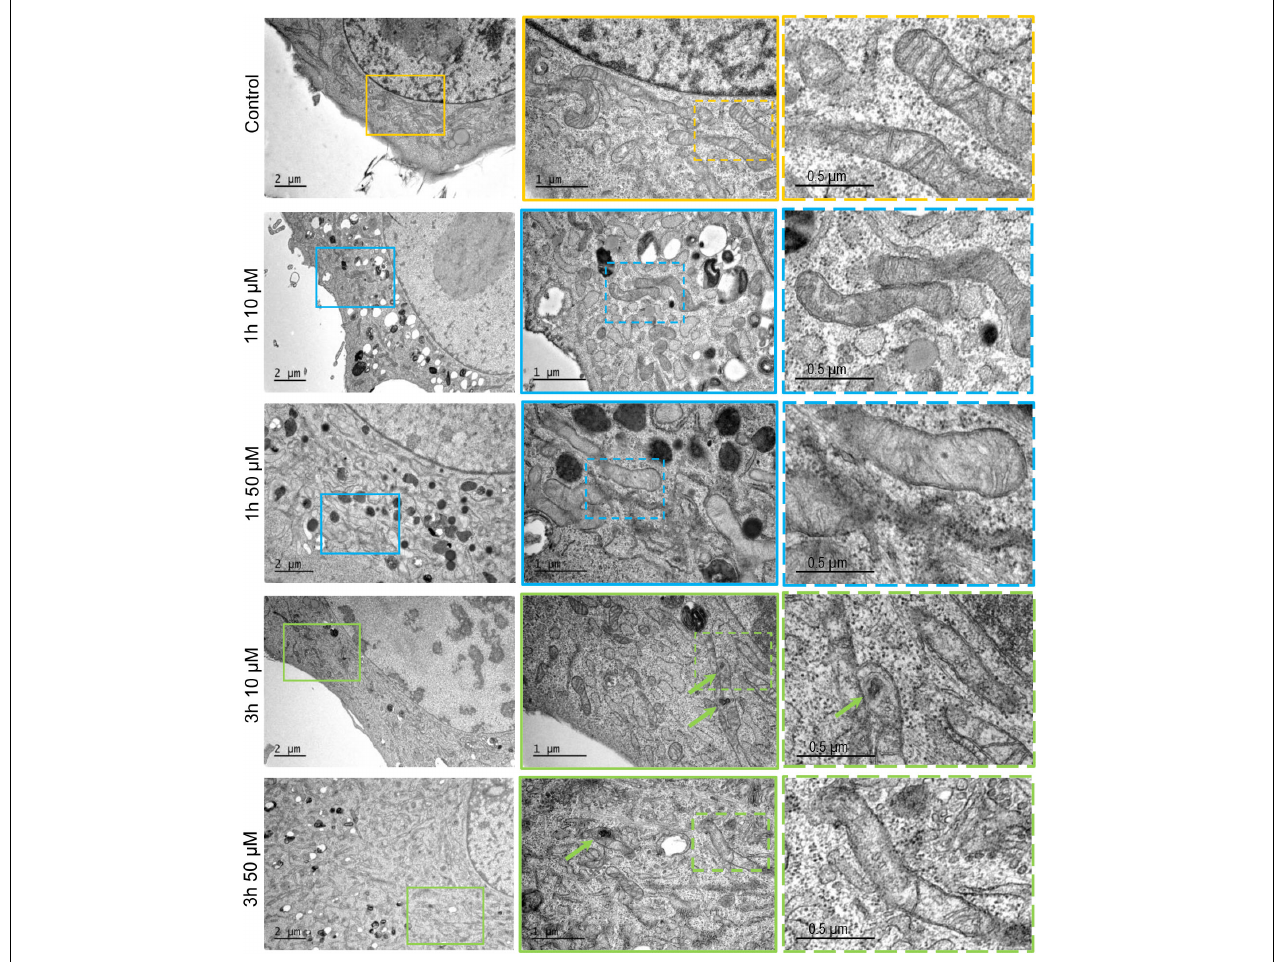
FIGURE 2 | Visualization of mitochondria and their ultrastructure in fibroblasts treated with 3O-C 12 -HSL. Cells were either treated with 0.02% DMSO as a diluent (Control), or 10 and 50 µ M 3O-C 12 -HSL for 1 or 3 h. Samples were fixed, stained with uranyl acetate and imaged by TEM. The data are from one of three independent experiments. Left panel, bar: 2 µ m. Middle panel, bar: 1 µ m. Right panel, bar: 0.5 µ m. Size of zoomed inserts in the right panel is 1.3 µ m × 1.5 µ